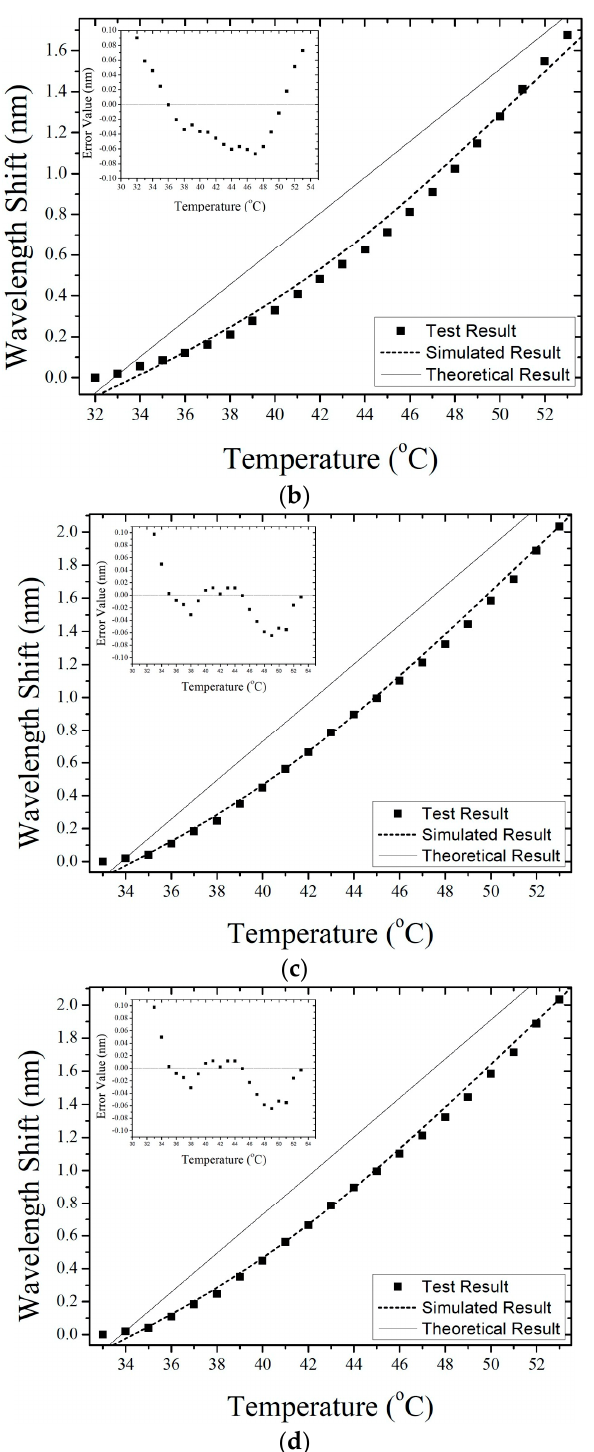
Figure 12. Wavelength shift versus temperature for different intracavity pressures: ( a ) 0.01 MPa; ( b ) 0.03 MPa; ( c ) 0.04 MPa; ( d ) 0.05 MPa.